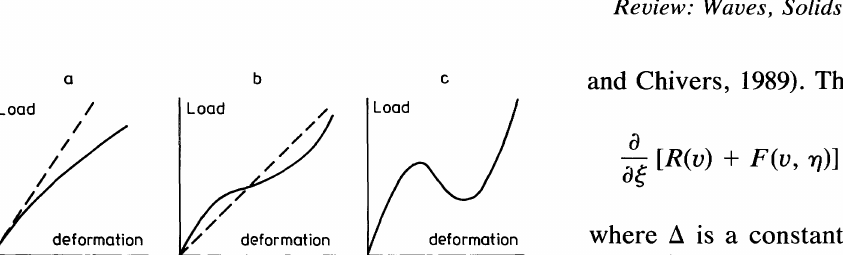
FIGURE 1 Load-deformation curves: (a) monoto nous response; (b) convex-concave response; (c) lo cal unstable